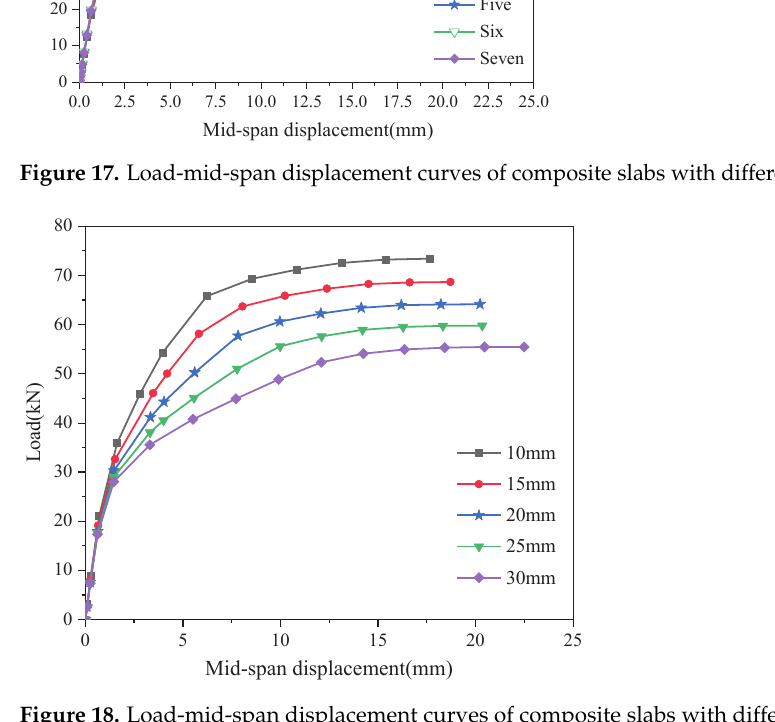
Figure 18. Load-mid-span displacement curves of composite slabs with different cover thickness. For composite beams, Figure 19 shows the load-mid-span displacement curves of steel–UHPC composite beams with different U-rib thicknesses. It can be seen from the figure that with the increase in U-rib thickness, the stiffness of each member from the elastic stage to the crack propagation stage is significantly improved. This is because the U-rib